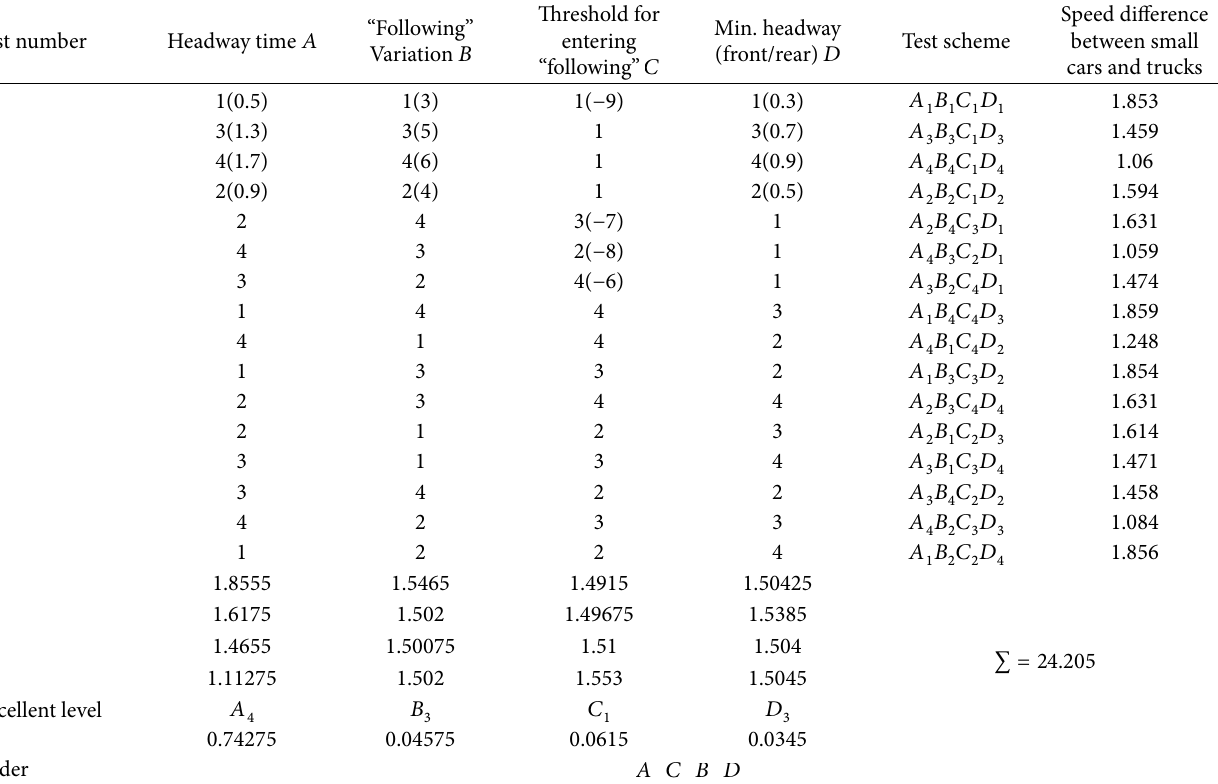
Table 4: Orthogonal experimental design.